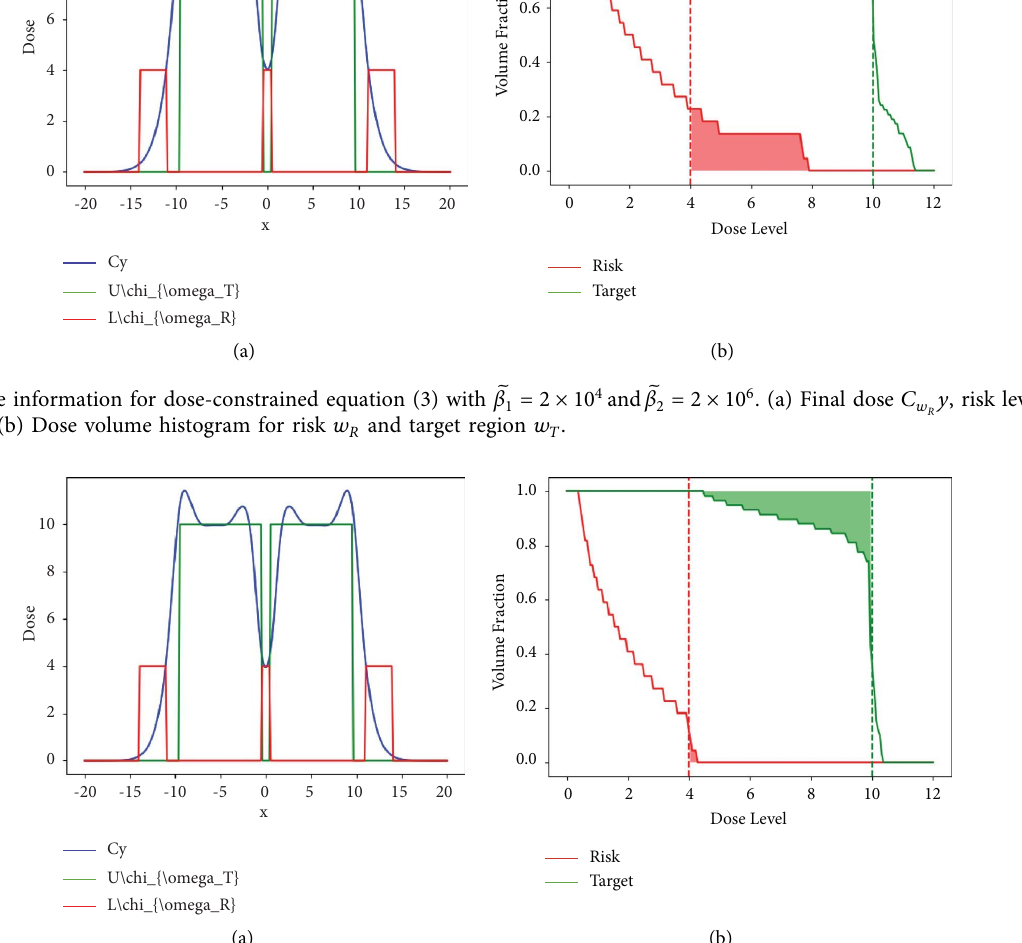
� 1 . 25 × 10 4 and 􏽥 β � 2 × 10 6 . (a) Final dose C y , risk level L , and w R 1 2